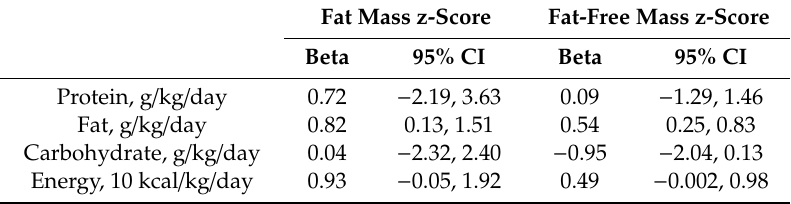
Table 4. Associations of nutrient intakes with body composition at term equivalent age ( n =